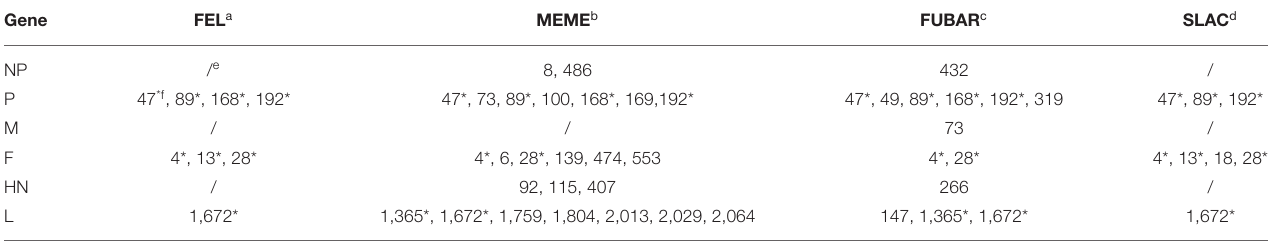
TABLE 4 | The selection profile of different genes of PPMV-1 in